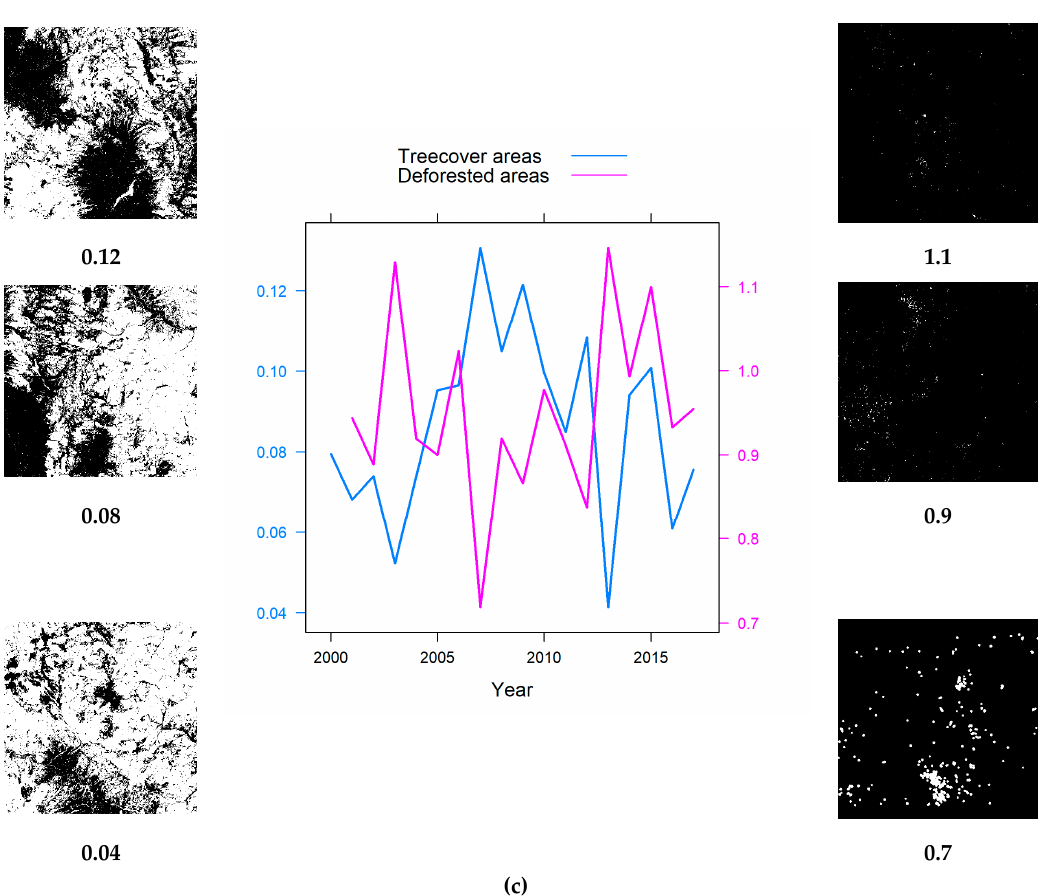
Figure 7. (a) The GLCM Entropy dynamics induced by the computer ‐ generated patterns ‐ tree cover (left) and deforested areas (right) ‐ as a function of their values. (b) The FFI dynamics induced by the computer ‐ generated patterns—tree cover (left) and deforested areas (right)—as a function of their values. (c) The Λ T ‐ o ‐ W dynamics induced by the computer ‐ generated patterns—tree cover (left) and deforested areas (right)—as a function of their values.